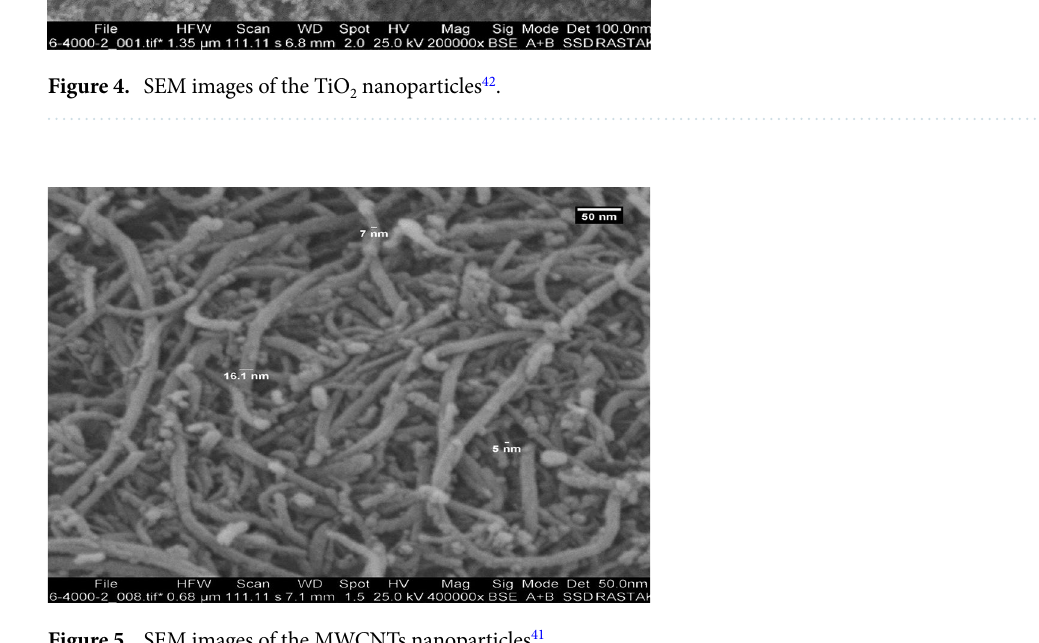
Figure 5. SEM images of the MWCNTs nanoparticles 41